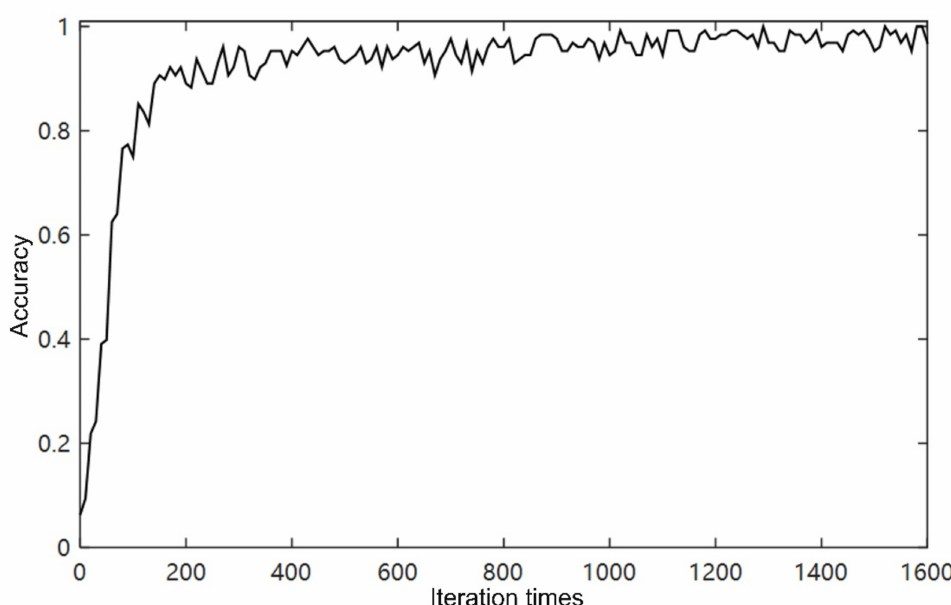
Figure 3. Accuracy of one-dimensional convolutional neural network.